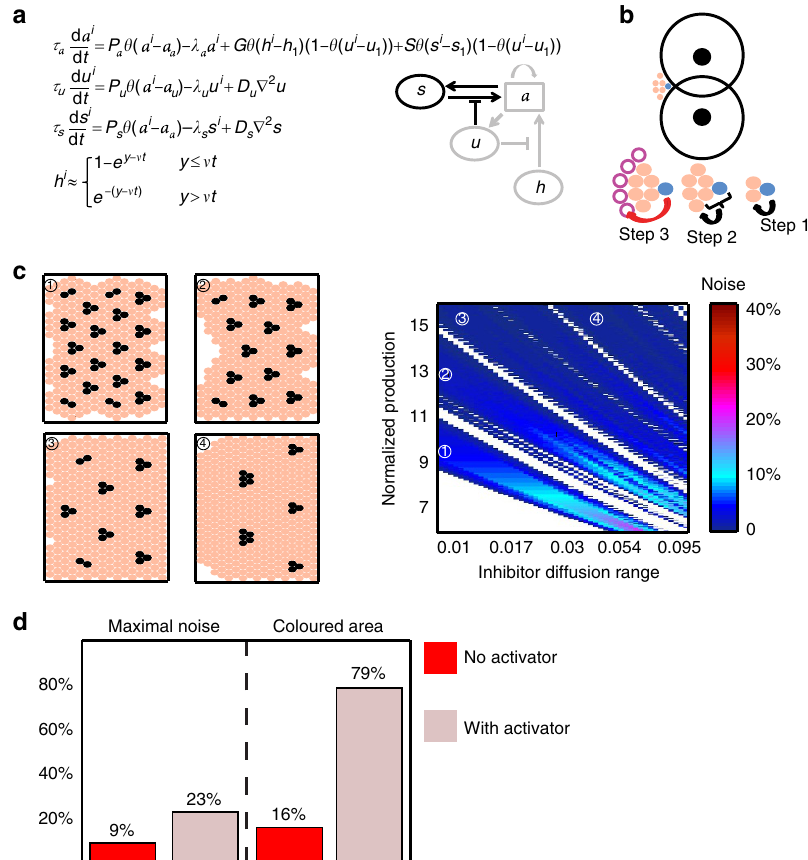
Figure 3 | An extended model including a short-range activator. ( a , b ) The extended model including a diffusible activator s . Shown are the model’s equations, the scheme of the interactions and illustration of the activating dynamics. t s , P s , l s , D s are the respective timescale, production rate, degradation and diffusion constants of the short-range activator added to the template-based lateral-inhibition patterning model. In b , black arrows depict progression of the short-range activator signal and the red arrow depicts that of the inhibitor. ( c ) Reduced sensitivity of the model to spatial heterogeneity. Sensitivity analysis for the extended model is shown, similar to the one conducted for the original model. See Supplementary Note 6 and Supplementary Fig. 3 for details and Supplementary Tables 1 and 2 for parameters. ( d ) Quantitative comparison of the robustness with or without the addition of the short-range activator. Left panel compares the maximal noise that could be added in simulations shown in c to that in simulations in Fig. 1e (no activator). Right panel compares the area of the coloured regions in these simulations, where patterns could be